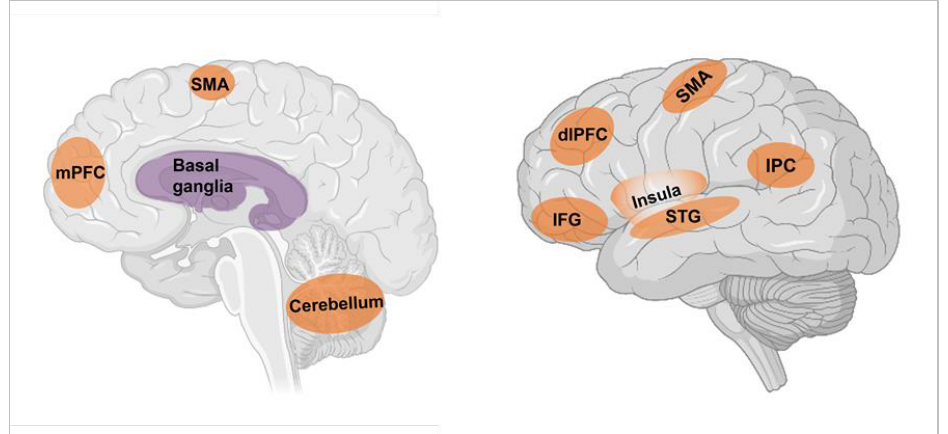
Figure 2. Brain regions typically implicated in prospective time perception, as revealed by fMRI studies in healthy young adults. dlPFC: dorsolateral prefrontal cortex; IFG: inferior frontal gyrus; IPC: inferior parietal cortex; mPFC: medial prefrontal cortex; SMA: supplementary motor area; STG: superior temporal gyrus. Brain template by BioRender.com (accessed on 22 March